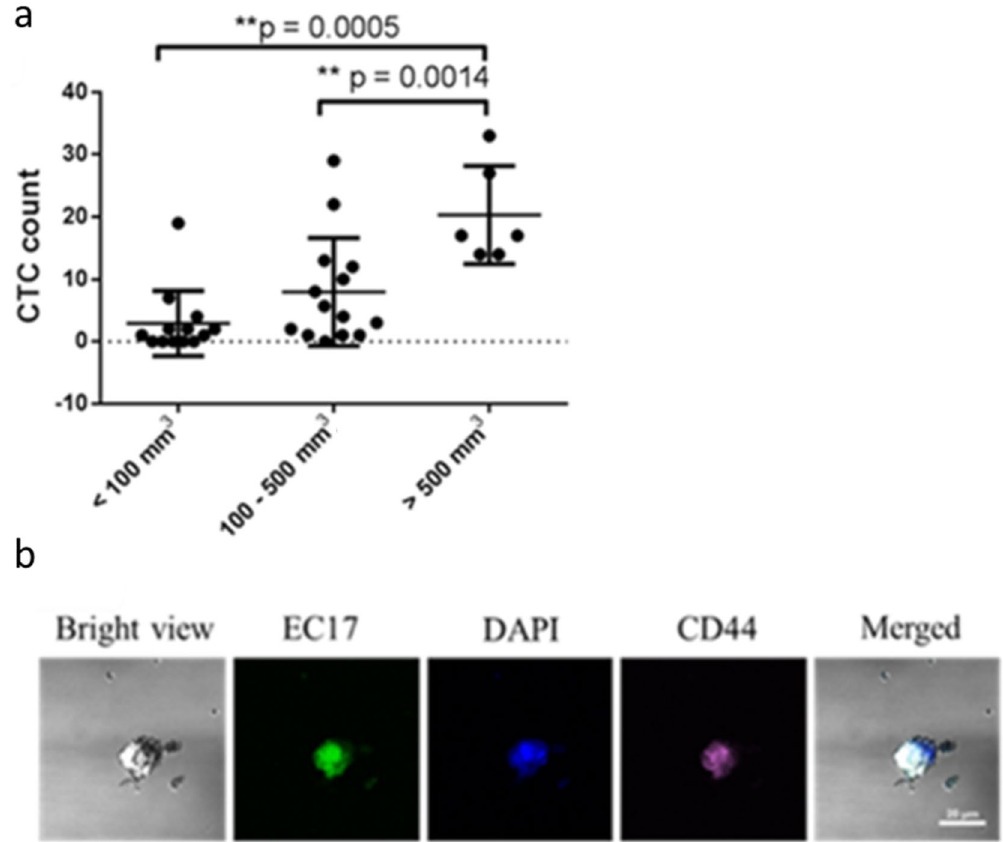
Figure 5. ( a ) Correlations between tumor volume and CTCs captured by folate-biotin coated beads from ~ 200 μL of mouse blood (n > 6). MDA-MB-231 cells were injected subcutaneously into nude mice to build the solid tumor model. Data were analyzed using one-way ANOVA, followed by post hoc Tukey test (** P < 0.0005– 0.0014). ( b ) CTCs were captured by folate-biotin coated beads. Captured cells were stained with fluorescently labeled folic acid, folate-FITC (EC17), DAPI or anti-CD44 antibody to label cancer cells, nuclei and stem-like cells,